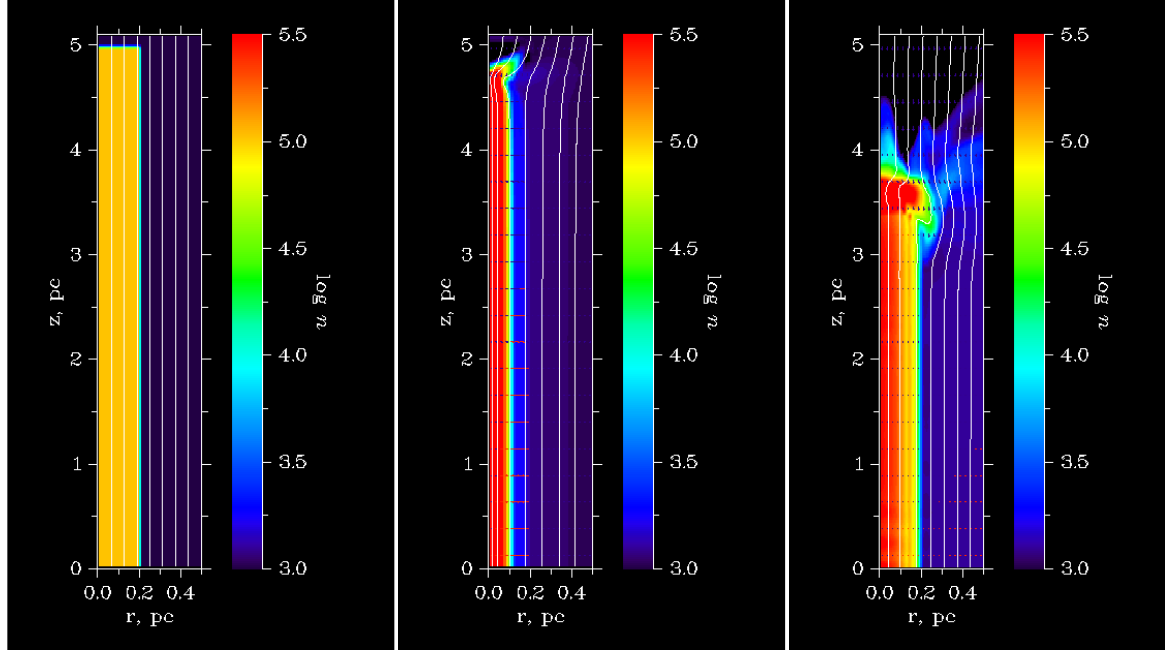
Figure 2. Two-dimensional concentration (color filling) and magnetic field (white isolines) distributions for the adiabatic cylinder with mag- netic field at t = 0 yrs (initial state, left), t = 1.21 × 10 5 yrs (center), 3.72 × 10 5 yrs (right) after the beginning of the collapse.